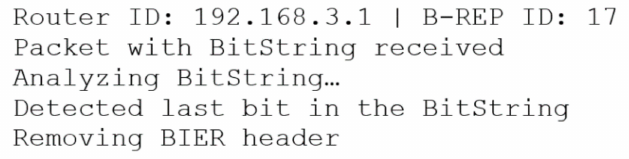
Figure 18. Output from R16—decapsulation